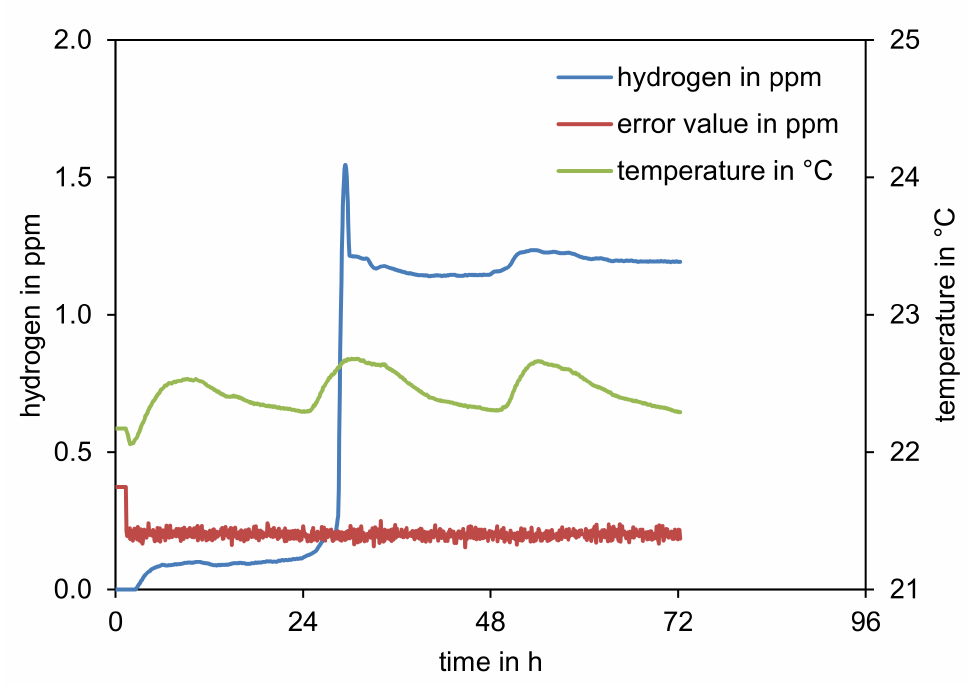
Figure 2. Result graph of the H-sensor of a case-hardened disc made of the material